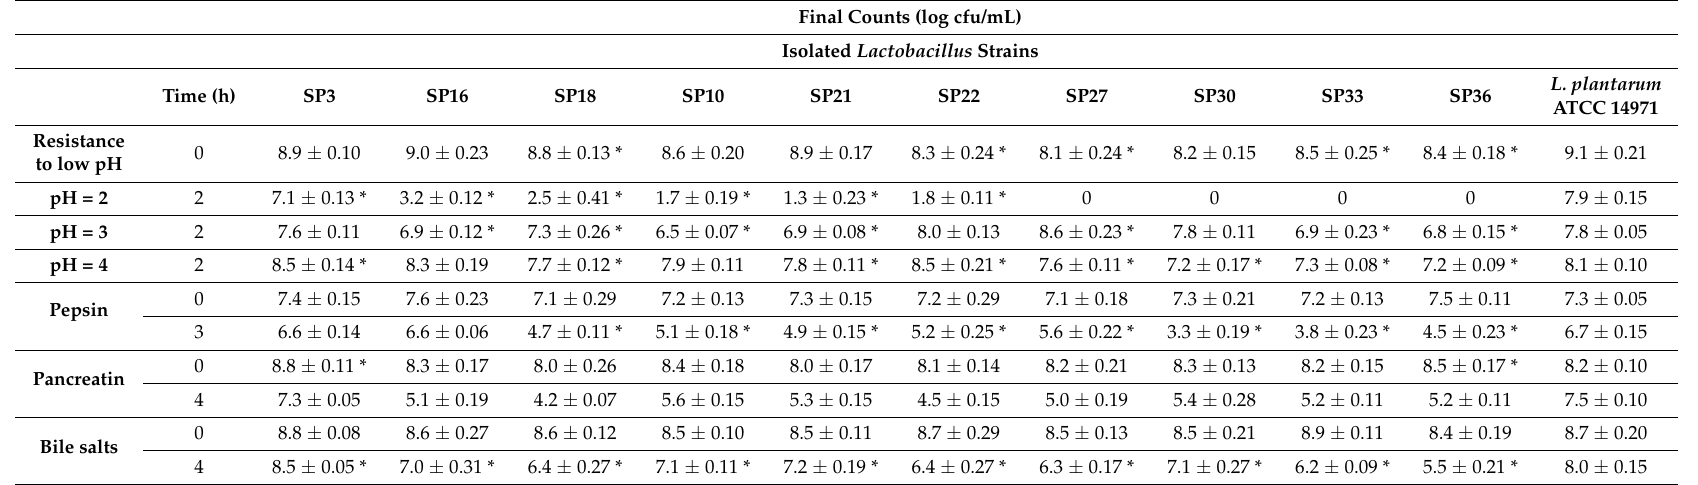
Table 1. Assessment of viability of the isolated strains after exposure to low pH, bile salts, pepsin and pancreatin. In all tests, the probiotic L. plantarum 14917 served as a reference